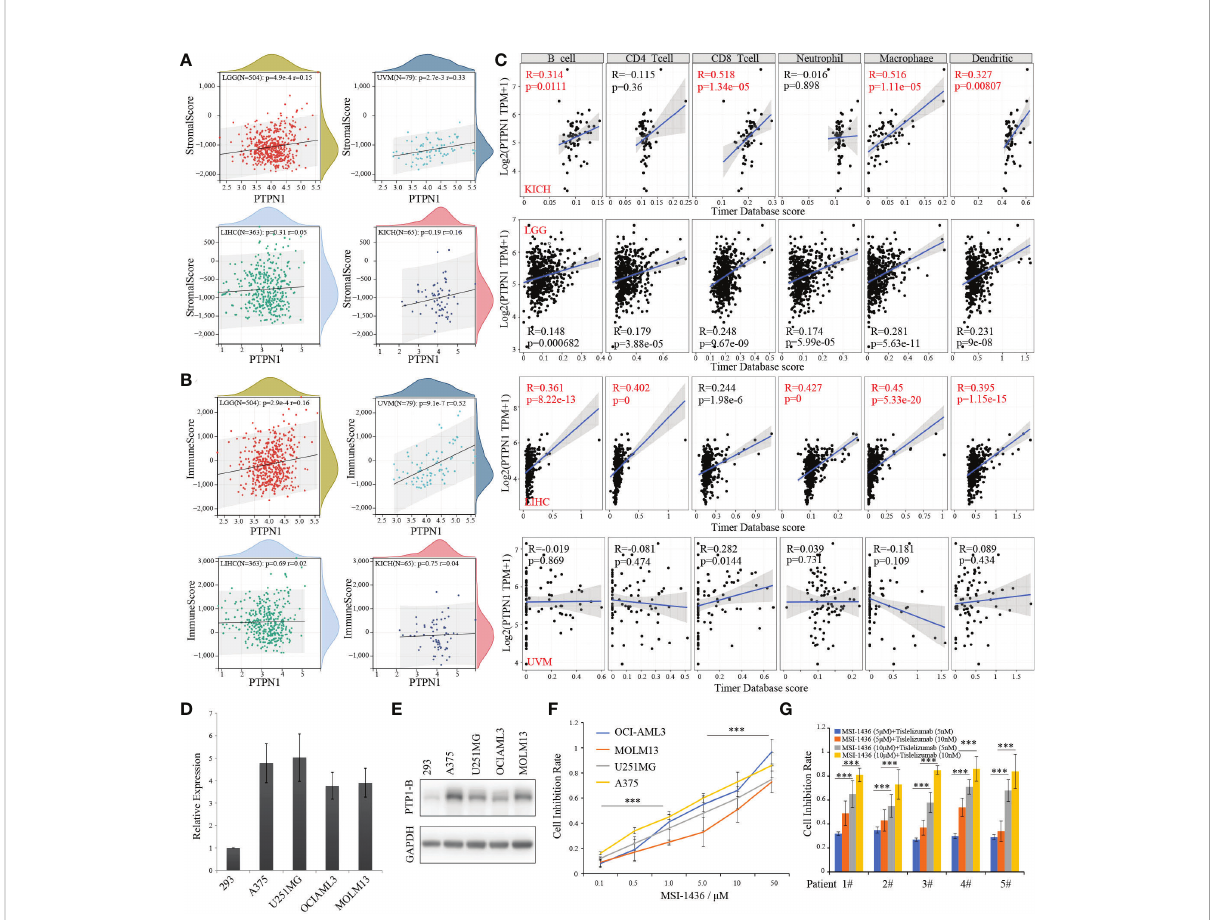
FIGURE 6 PTP1B, immune in fi ltration and CSCs index in cancers. (A, B) The correlation of PTP1B expression and stromalscore (A) or immunescore (B) in LGG, UVM, LIHC and KICH. The p value and correlation coef fi cient (r) were showed. (C) Immune in fi ltration of PTP1B in these four cancers. The correlation coef fi cient (r) was calculated by Pearson. (D) Relative PTP1B RNA expression validated in 293 and other cancer cell lines including A375, U251MG, OCI-AML3 and MOLM13 by qPCR. (E) Protein expression level of PTP1B in these cancer cell lines. (F) The cell inhibition rate of MSI-1436 (a PTP1B inhibitor) in different cancer cell lines with different doses. (G) Sensitivity effect of MSI-1436 and PD1 inhibitor (tislelizumab) in AML patient samples. ***p <